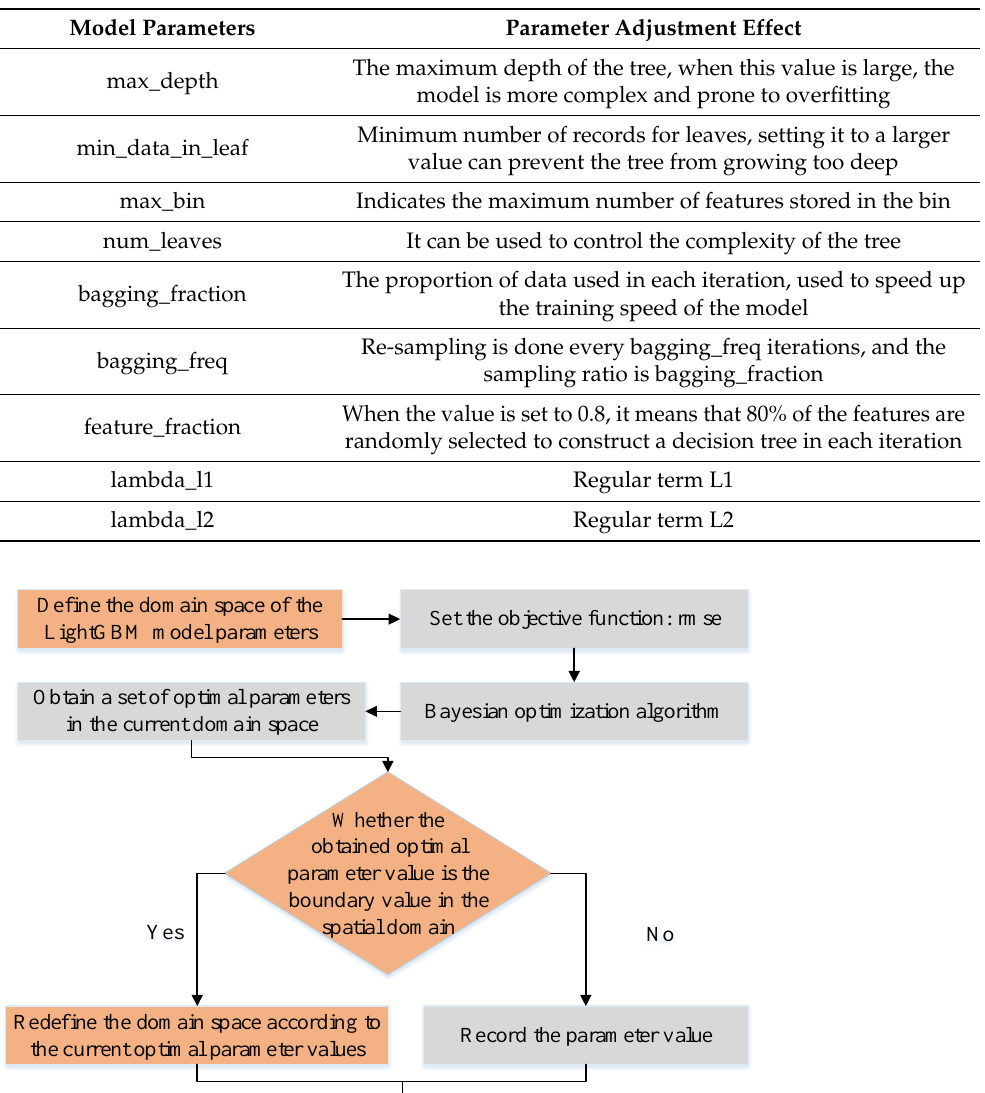
Table 3. LightGBM model parameters.